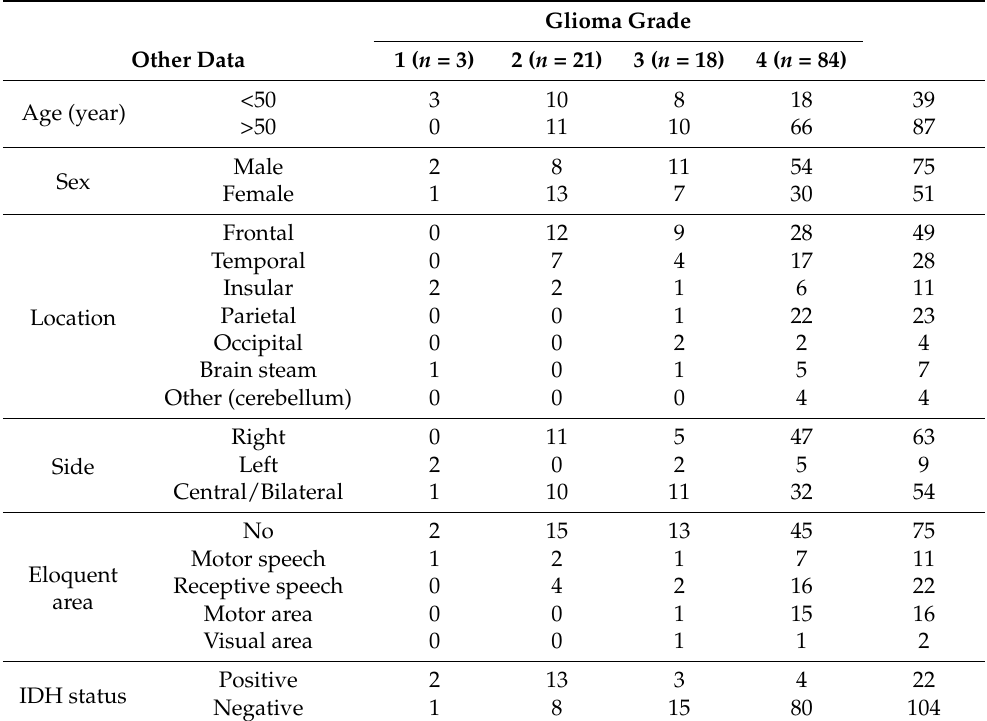
Table 1. Additional demographic data on our study